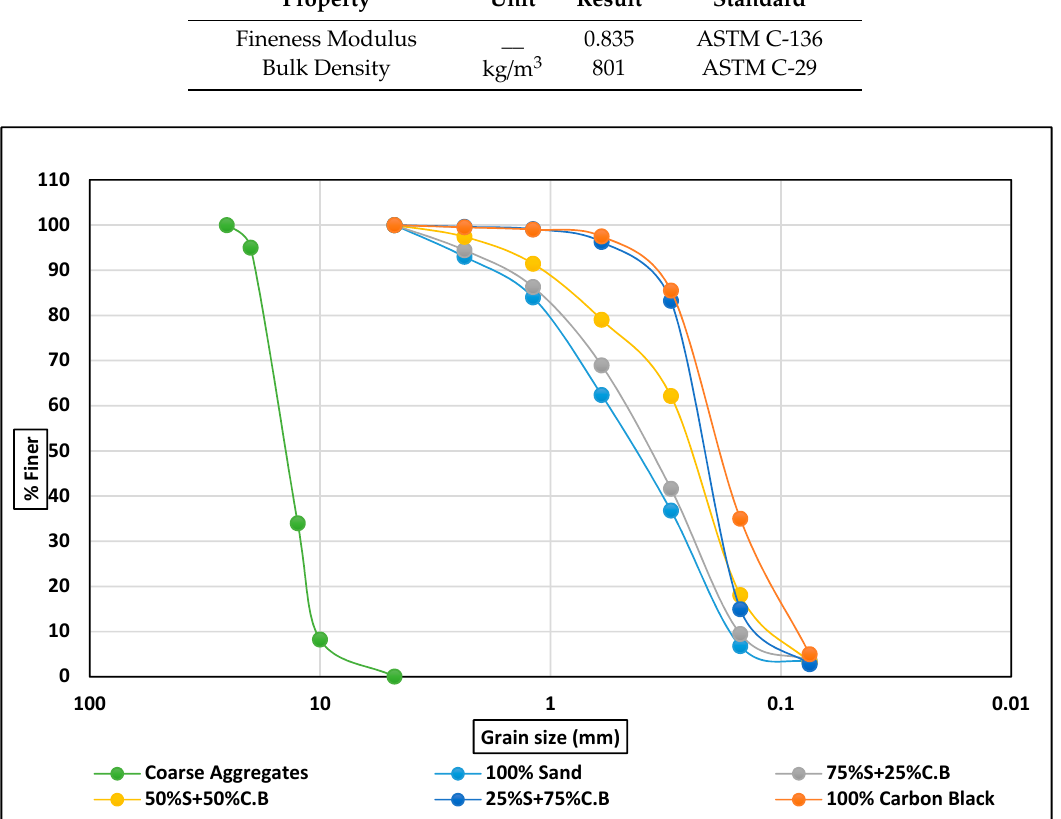
Figure 1. Gradation curve of aggregates.